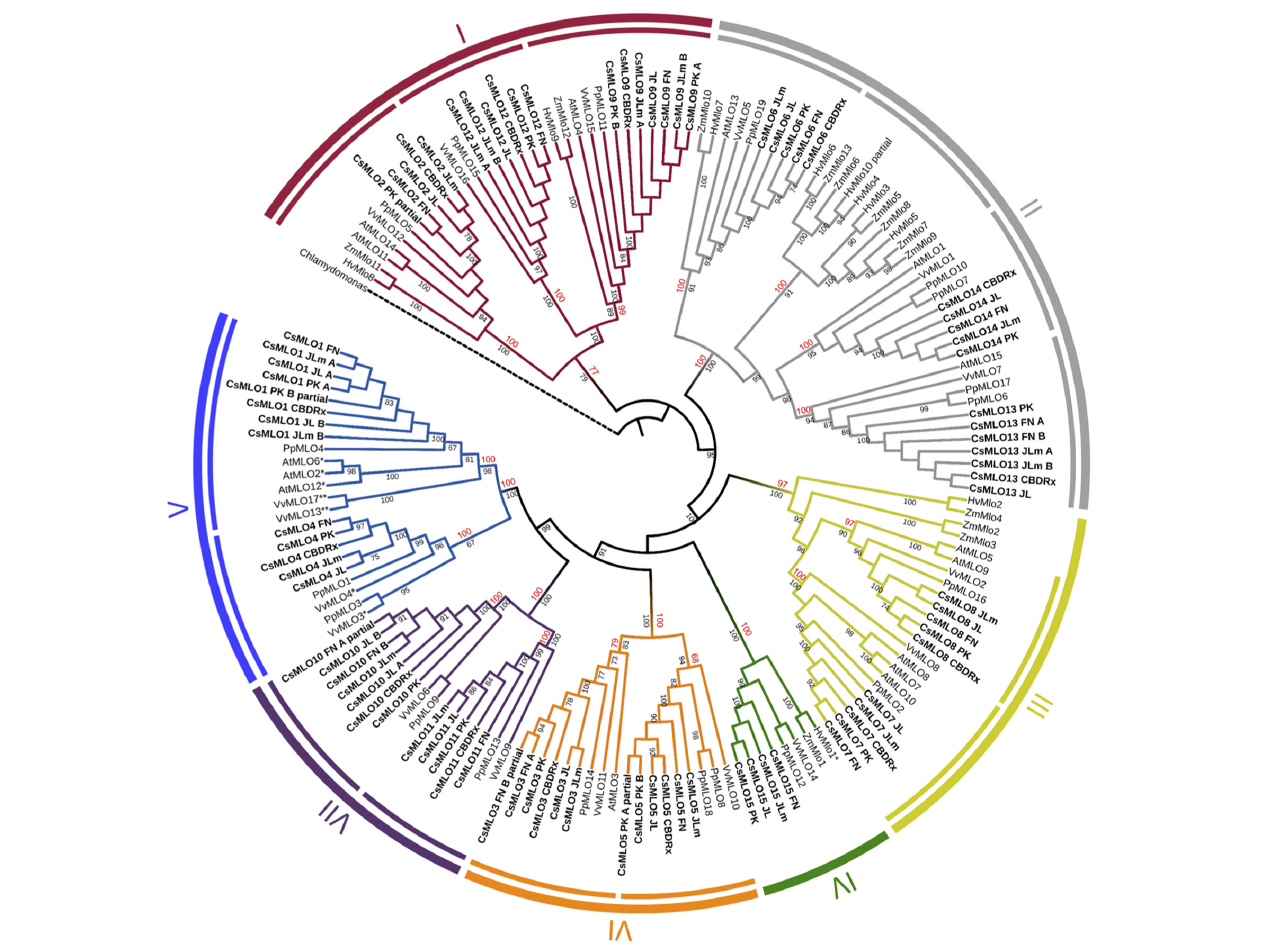
FIGURE 3 | Phylogenetic relationships of CsMLOs based on maximum likelihood analysis. Phylogenetic tree of manually curated CsMLO proteins (bold) with MLO proteins from selected species ( Arabidopsis thaliana , Prunus persica , Vitis vinifera , Hordeum vulgare , and Zea mays ). Chlamydomonas reinhardtii was used as an outgroup. Phylogenetic relationships were estimated using the maximum likelihood method implemented in PhyML + SMS with 1,000 bootstrap independent replicates. The seven defined clades are indicated, as well as potential subclades identified in this study (inner circles). Number on a node indicates the percentage of bootstrap when higher than 65% (black), or the posterior probabilities of major clades and subclades, according to a Bayesian phylogenetic inference performed on the same alignment (red) ( Supplementary Figure 1 ). MLOs with one asterisk (*) have been experimentally demonstrated to be required for PM